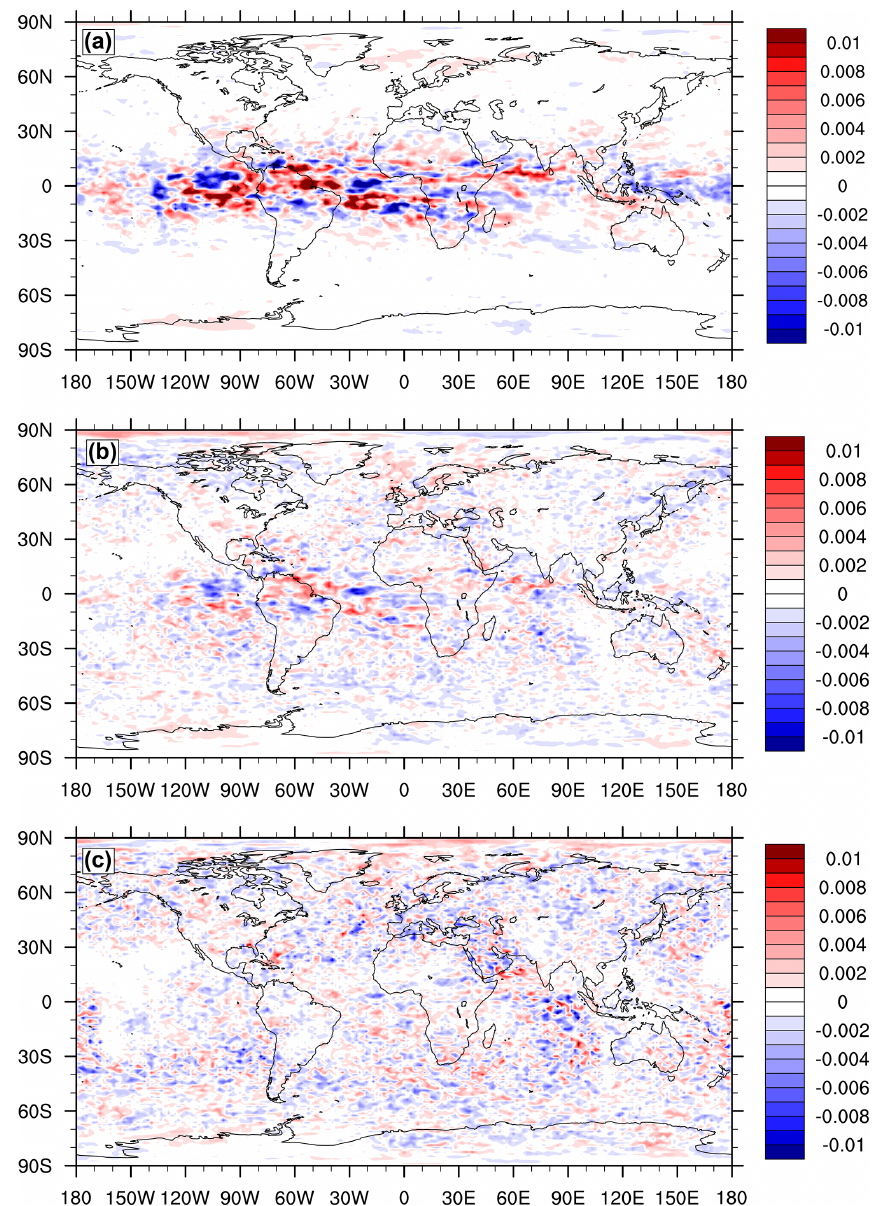
Figure 7. Global distribution of the modelled fractional cloud cover difference ( (cid:49)C C ) between Run C (i.e. the new dry deposition scheme and the new LNO x scheme) and the base run (mean over 2006–2010). The plots are for (a) high level ( > 6km), (b) middle level (2–6km) and (c) low level ( < 2km)